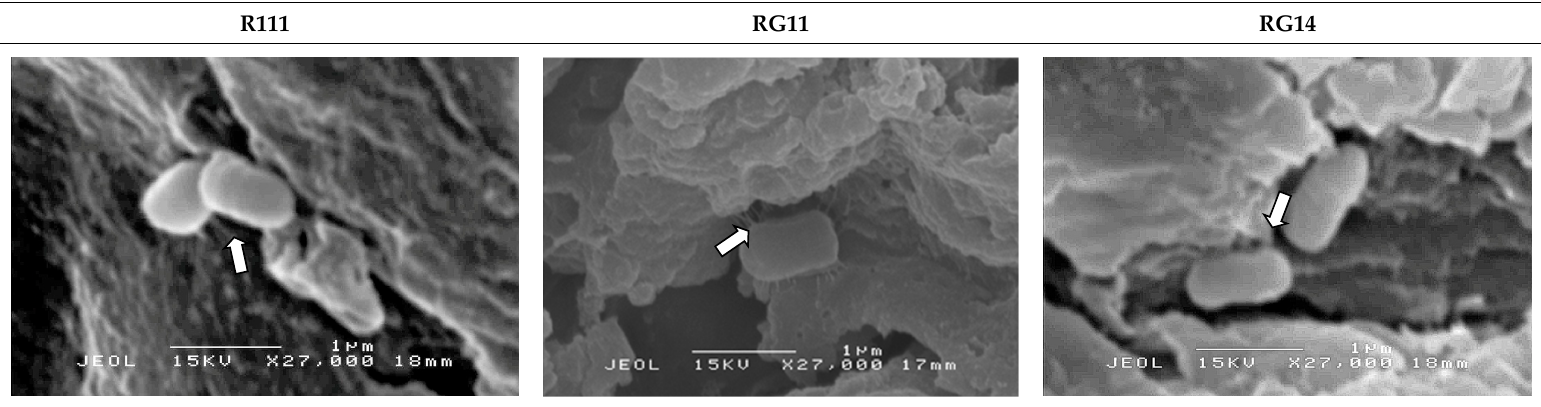
Figure 6. Scanning electron micrograph of exopolysaccharide formation of selected Lactobacillus plantarum strains on palm kernel cake at Day 6 of solid-state fermentation (Bar: 1 µ m). Abbreviations: R111, L. plantarum R111; RG11, L. plantarum RG11; RG14, L. plantarum RG14. White arrows show the appendages of extracellular polysaccharides matrices formed around the cell surface of selected L. plantarum strains which allowed them to hold and attached well to the PKC surface during the SSF of PKC